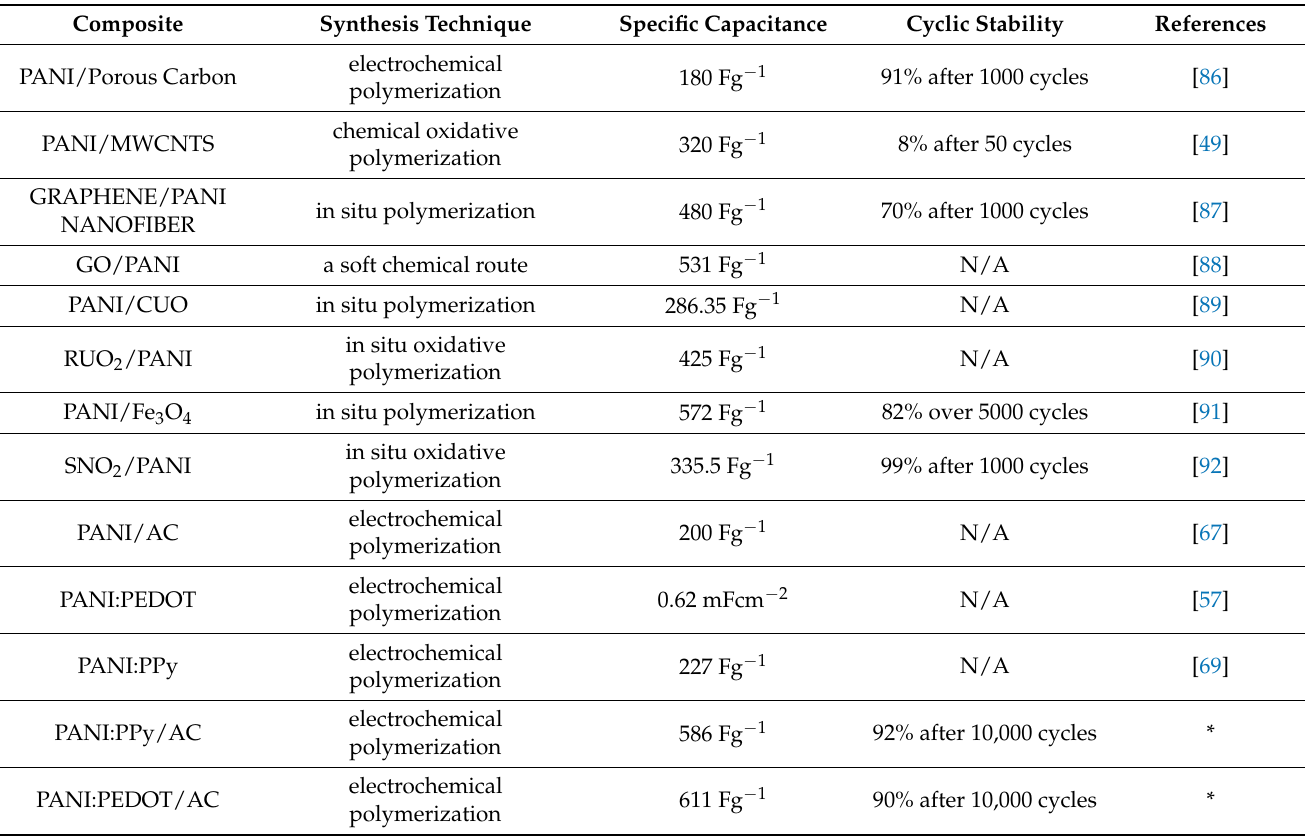
Table 3. Synthesis methods and electrochemical performance of reported PANI-based composites as supercapacitors electrode